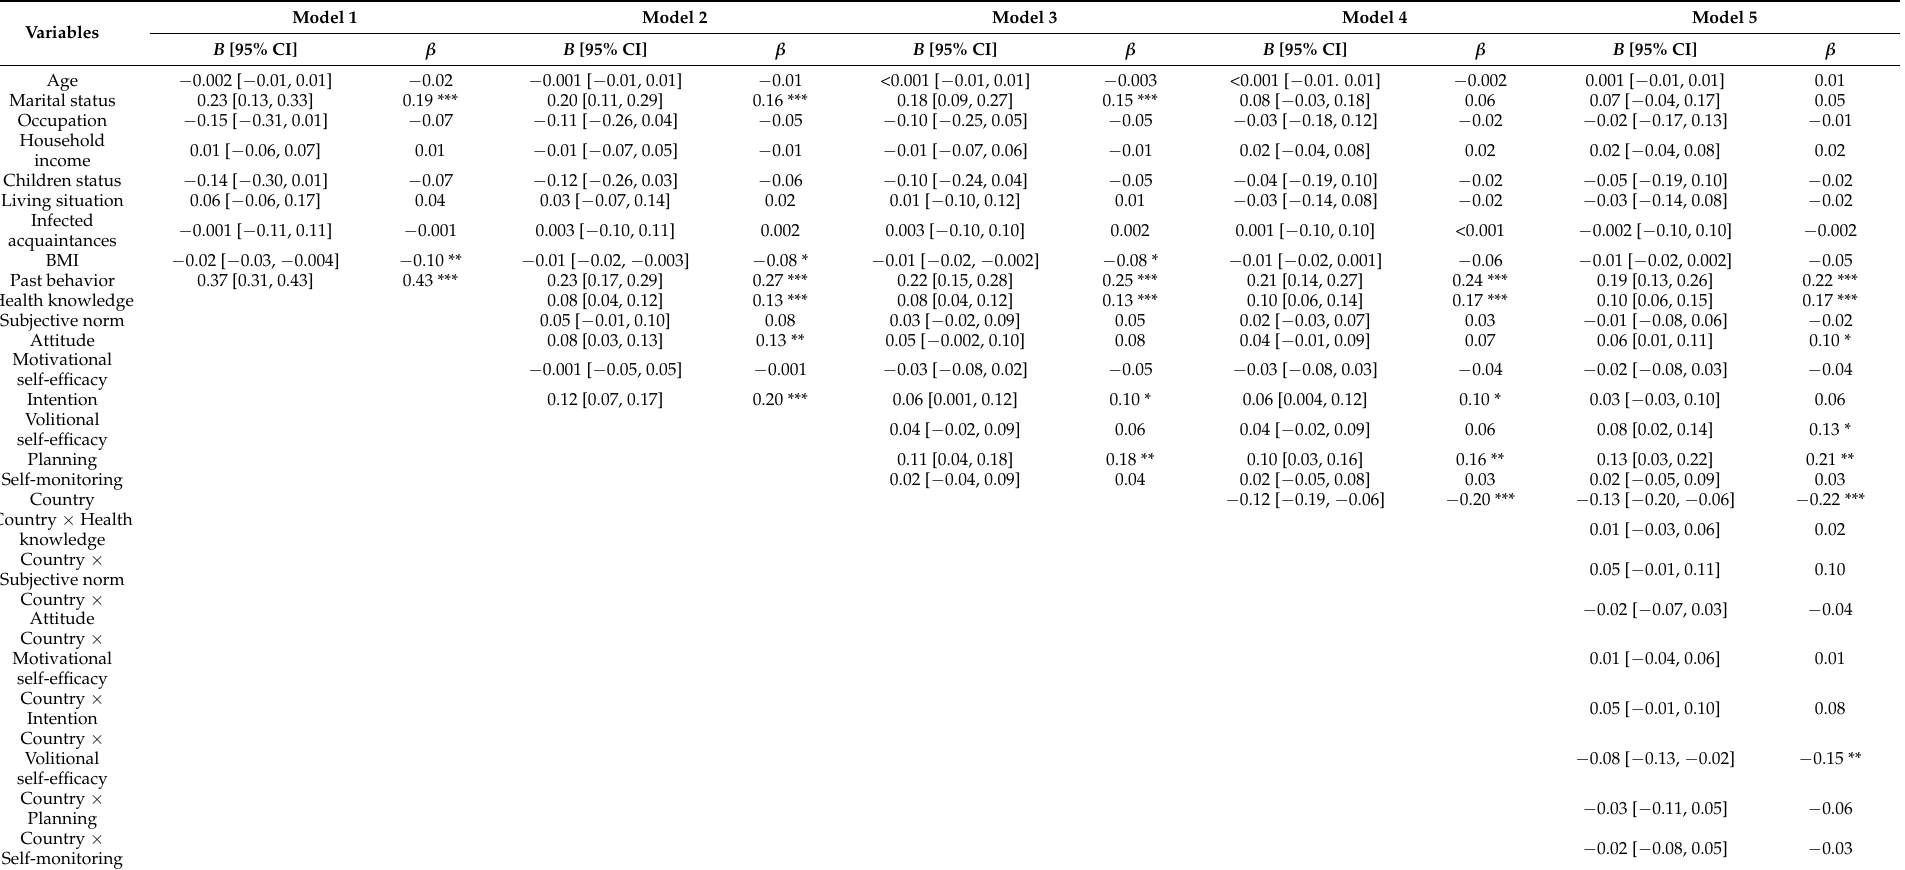
Table 3. Multiple hierarchical regression results for prediction of hand washing behavior ( n =